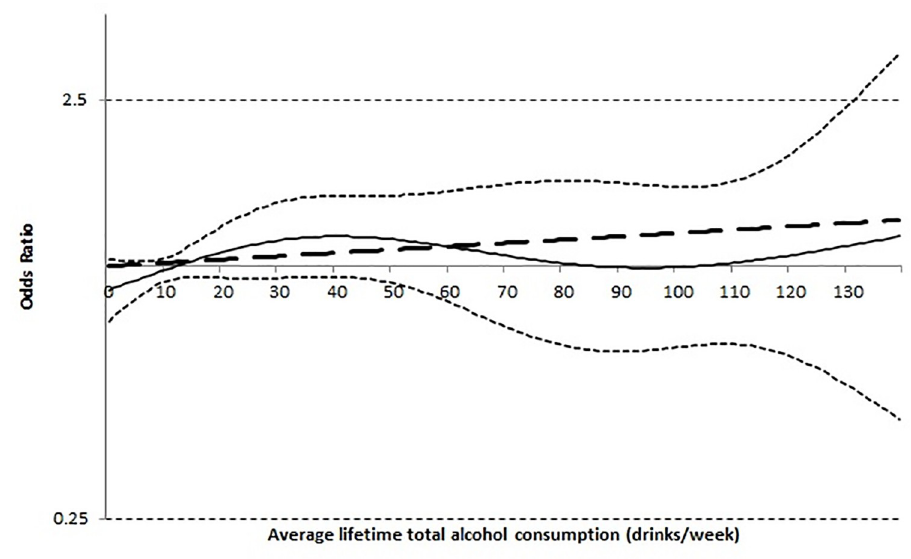
Fig 1. Dose-response relation of average lifetime total alcohol consumption (drinks/week) on risk of gastric intestinal metaplasia. (a) solid line = odds ratio; (b) dotted line = 95% confidence interval for odds ratio; (c) dashed line = null hypothesis of no association; (d) extended dashed line = linear association.